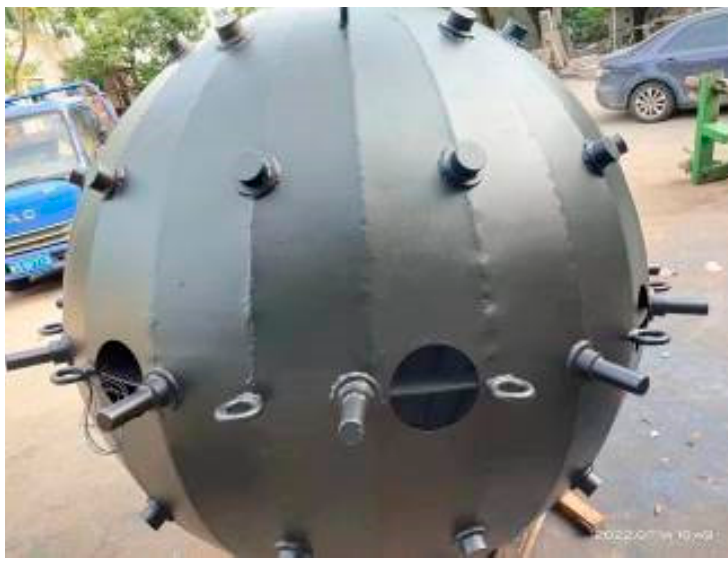
Figure 17. Mine model produced by 3D printing.